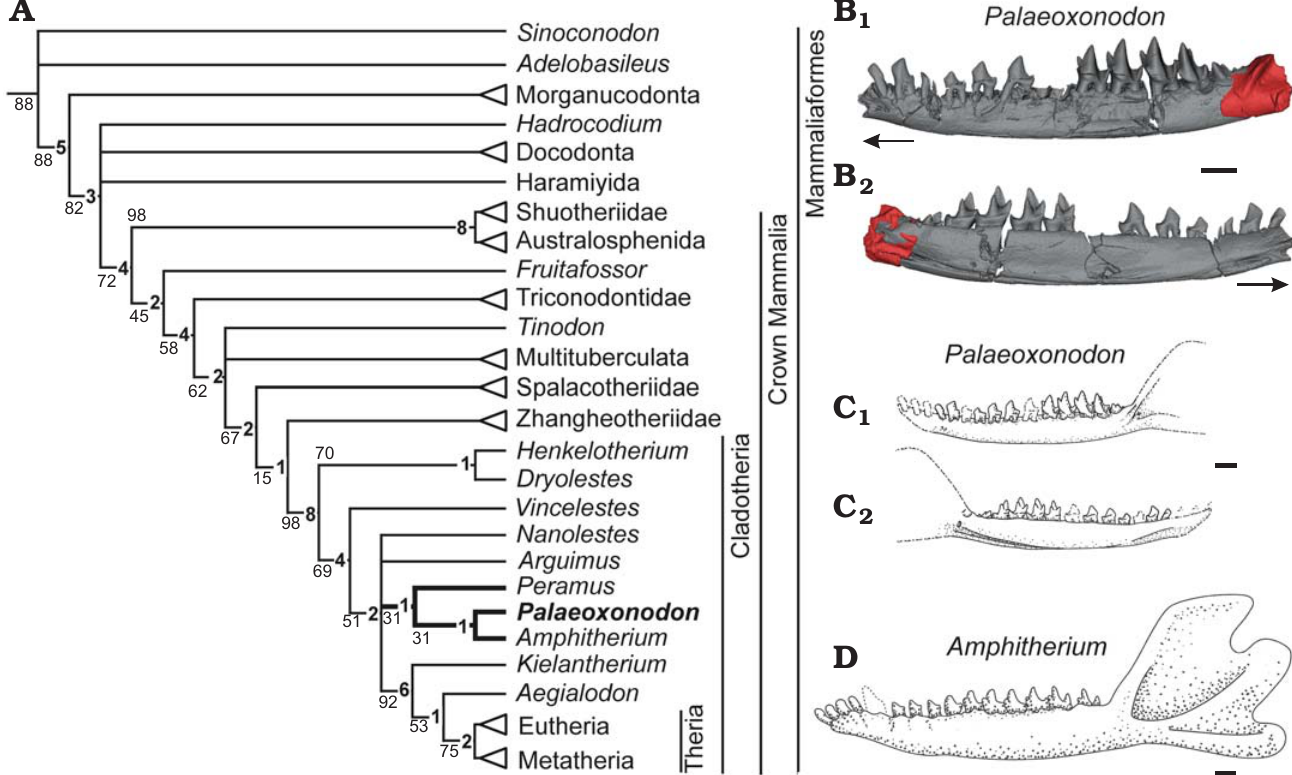
Fig. 3. Parsimony analysis and reconstructions of dentary of Palaeoxonodon ooliticus (B, C), with Amphitherium (D) for comparison. A . Equally weighted parsimony analysis with additional mandibular characters for the early cladotherian Palaeoxonodon ooliticus , and rescored and updated matrix from Close et al. 2016 (adapted from Zhou et al. 2013). Jackknife resampling statistics and Bremer values (bold) are shown adjacent to individual nodes. B . Composite of NMS G. 2015.17.1 (grey) and coronoid of NMS G.2017.37.1 (red) in buccal (B 1 ) and lingual (B 2 ) views (arrows indicate anterior direc- tion). Data for NMS G. 2015.17.1 from Close et al. (2016). C . Reconstruction of jaw in buccal (C 1 ) and lingual (C 2 ) views. D . Reconstruction based on composite created by EP from NHMUK PV M.36822 and OUMNH J.20075 in buccal view. Scale bars 1